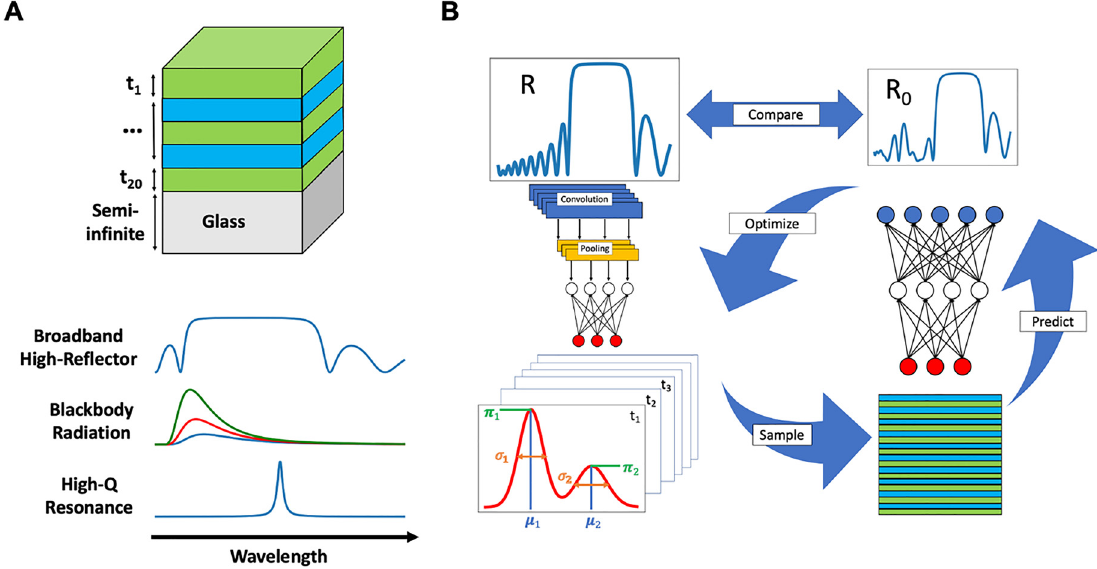
Figure 1: (A) Top: diagram of a 20-layer thin-film structure consisting of two alternating materials placed on a semi-infinite glass